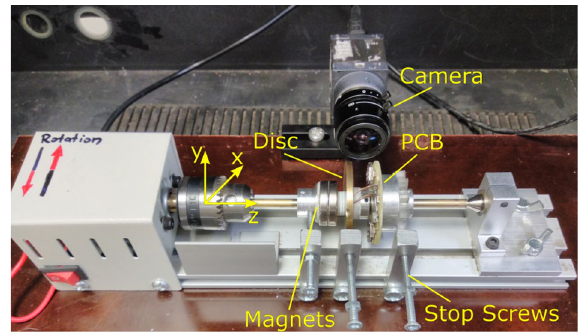
Figure 3. Photograph of the experimental setup. A right-handed system of coordinates is placed so that the brass shaft is coaxial with the z-axis. Neodymium magnets and brass disc are each glued to an aluminium sleeve, the measurement PCB is screwed to an aluminium sleeve with nylon screws. Each of the sleeves sits on bearings and can rotate with the shaft or be fixed with the help of dedicated stop screws as indicated in the